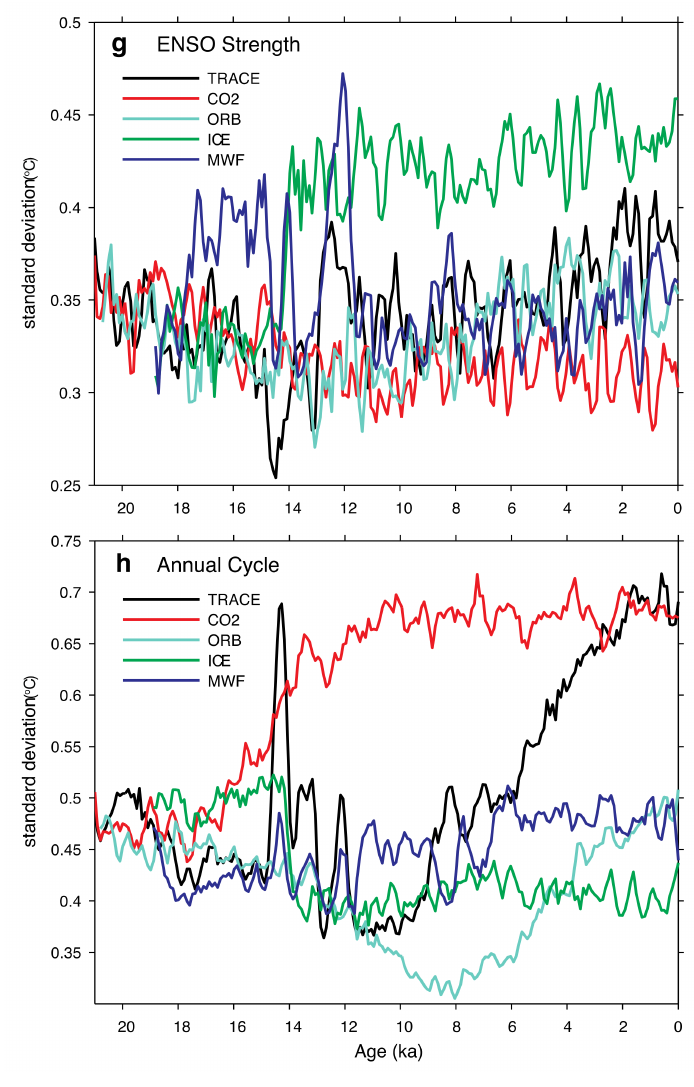
Figure 4. Modified from Figures 1 and 3 of Liu et al. [61]. ( a ) Grey, amplitude of annual cycle of insolation (December, January and February minus June, July and August (DJF–JJA)) at 30 ◦ S; black, meltwater flux into the North Atlantic (in equivalent sea level change in meters per 1000 years); ( b ) Red, Atlantic Meridional Overturning Circulation (AMOC) transport (in Sverdrups (Sv); 1 Sv = 10 6 m 3 s − 1 ); black and grey, 231 Pa/ 230 Th ratio in Bermuda; ( c ) Red, eastern Pacific north–south difference in annual SST (5 ◦ –15 ◦ N minus 5 ◦ –15 ◦ S, 140 ◦ –100 ◦ W); black, marine sediment records reconstruction of meridional SST gradient [29]. VPDB, Vienna Pee Dee Belemnite; ( d ) Red, Nino3.4 (170 ◦ –120 ◦ W, 5 ◦ S–5 ◦ N) annual SST; black, CO 2 reconstruction; ( e ) Red, ENSO amplitude (standard deviation of Nino3.4 interannual (1.5–7 years) SST variability) in 100-year windows from TRACE21 transient simulation [61]; black, lake sediment records in the eastern Pacific (El Junco) [24]; grey, lake sediment records on the South American coast (Laguna Pallcacocha) [22]. The green bars at 6 and 21 ka represent the median (solid) and 75th and 25th centiles (dashes) of ENSO amplitude changes in the mid-Holocene and Last Glacial Maximum (LGM) experiments in the PMIP2/PMIP3 ensemble (rescaled using TRACE21 ENSO in the late Holocene 2–0 ka); ( f ) Amplitude (standard deviation) of Nino3 (150 ◦ –90 ◦ W, 5 ◦ S–5 ◦ N) sea surface temperature (SST) total variability (less than 7 years) in 100-year windows. The black bars show the reconstruction of total SST variance derived from sediment cores in the eastern equatorial Pacific [29]; ( g ) Amplitude of ENSO and ( h ) Amplitude of the annual cycle in TRACE21 single forcing runs, both in 300-year